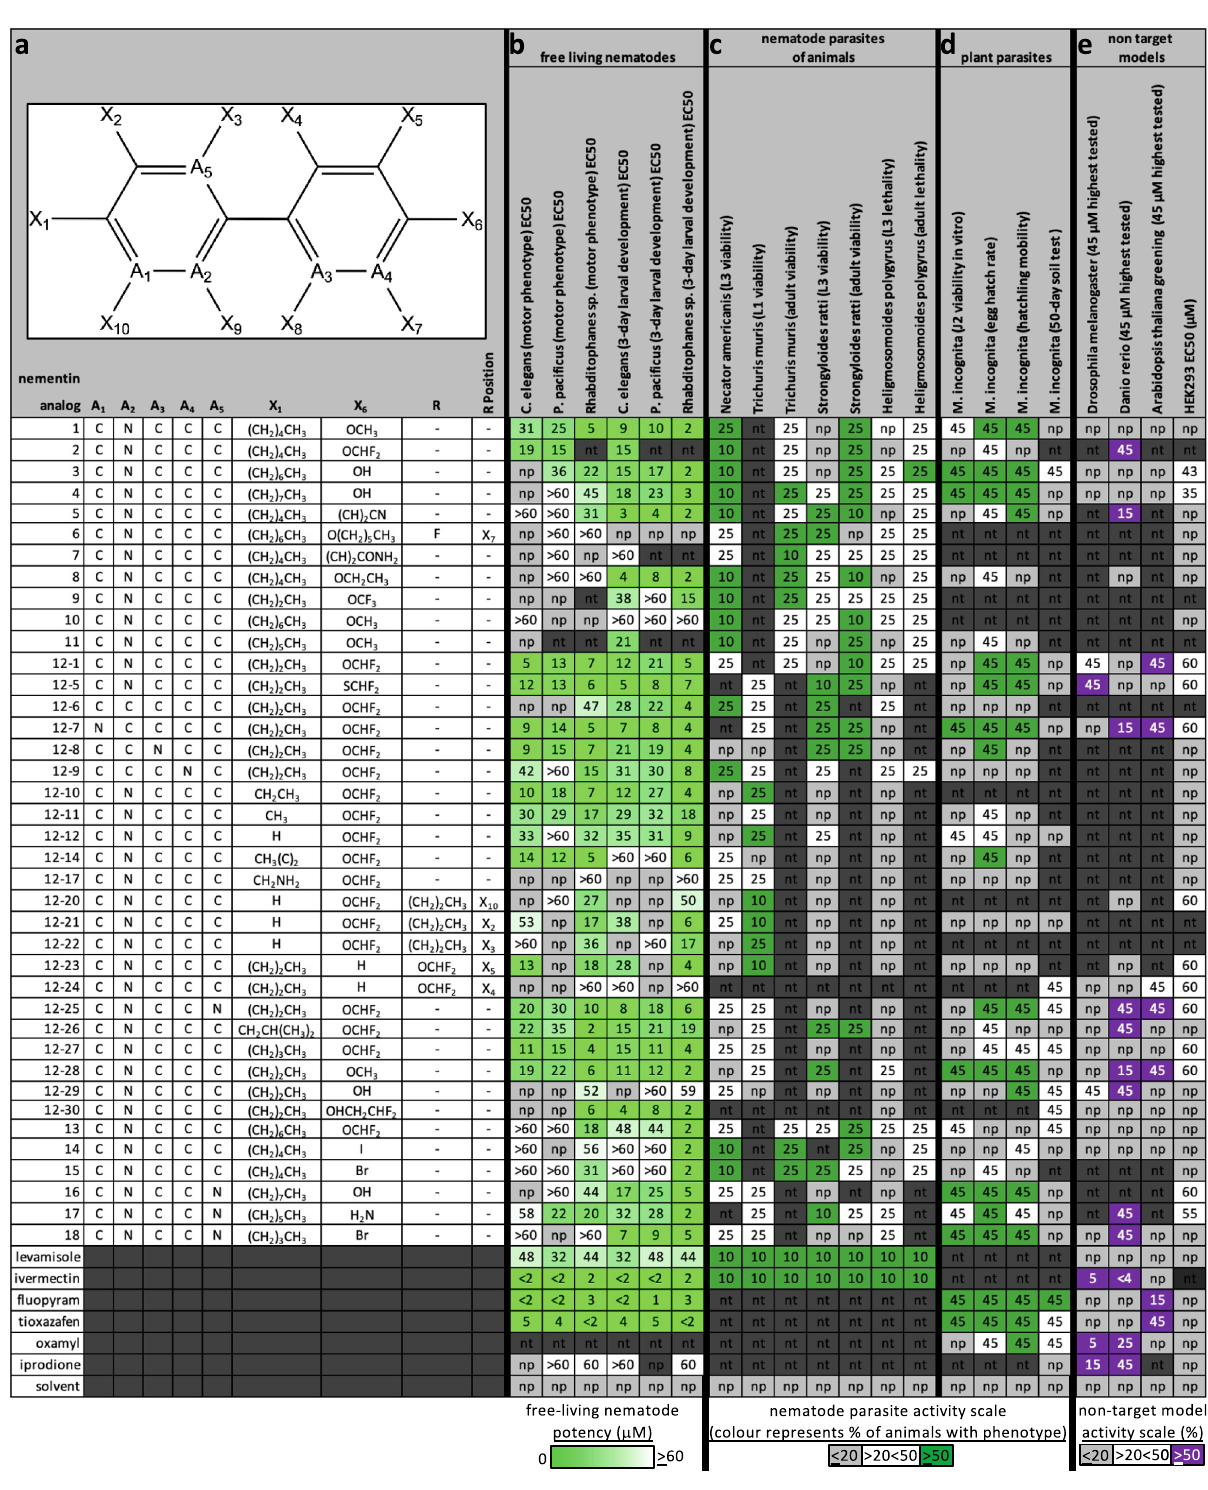
Fig. 6 Nementin structure-activity relationship analysis. a The analog structures are represented by the Markush structure at the top and includes atom and substituent identi fi ers. b Data for the free-living nematodes are EC50s ( µ M) and color-coded based on the potency scale at the bottom of this section. EC50s are generated from tests of a concentration series over n = 3 biologically independent trials. c , d Nematode parasites of mammals or plants were tested with a limited number of compound concentrations. In each cell in these sections, the lowest concentration ( µ M) tested that exhibited a phenotype is shown, and the percentage of animals that exhibit the phenotype is indicated by the color scale at the bottom of this section. e Data for models of non- targeted systems is reported either as an EC50 ( µ M) (for the HEK293 cells) or as the lowest concentration tested ( µ M) that exhibited a discernible phenotype compared to wild-type at the indicated concentration; the percentage of animals that exhibit the phenotype is indicated by the color scale at the bottom of this section. np no phenotype (<20% effect), nt not tested. See the Methods for a description of each assay. Primary data for this fi gure can be found in Supplementary Data